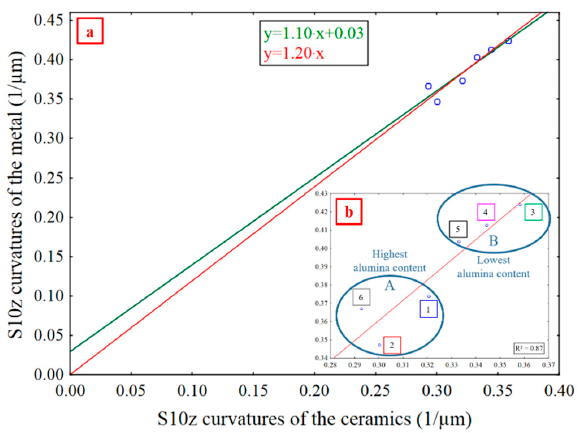
Figure 17. S10z curvatures of the metal vs S10z curvatures of the ceramics. Affine and linear approximations ( a ), and linear model ( b ). Ceramics and metal, mean curvatures, and a high pass filtering at 1286 μ m.